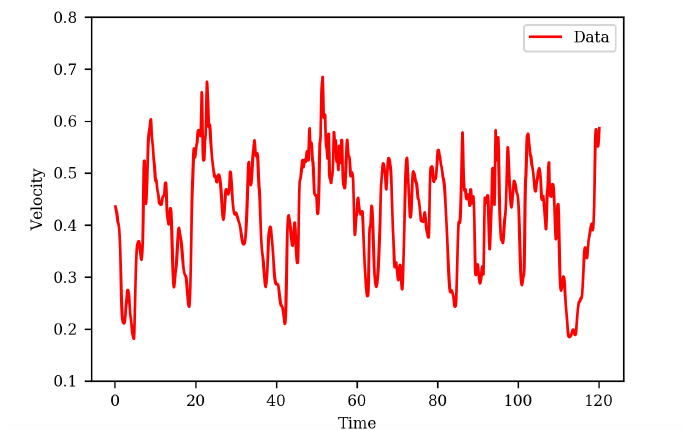
Figure 7. Raw velocity data from the